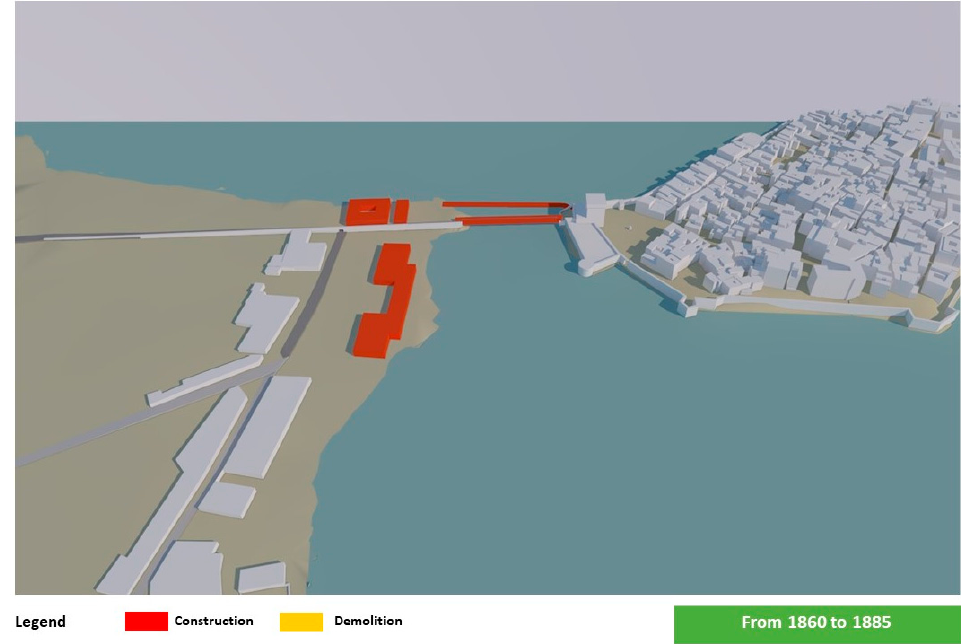
Figure A2. Three-dimensional model of differences between volumes built or demolished—from 1860 to 1885.